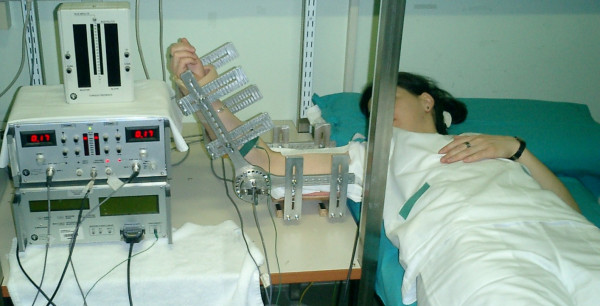
The experimental set up. The subject lies supine on a bed with the dominant arm horizontal and abducted to 90°. The forearm is 120° flexed (180° being full extension), with the hand supinated. The arm is placed in an isometric brace equipped with two torque transducers (one on each side of the arm) connected to a display that provides the subject with visual feedback of the torque level produced. The myoelectrical signals are picked up by a linear array of 16 electrodes placed on the skin overlying the biceps brachii muscle. The linear array can be identified as a white band on the biceps brachii.